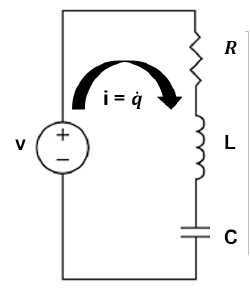
Figure 2. RLC electrical network